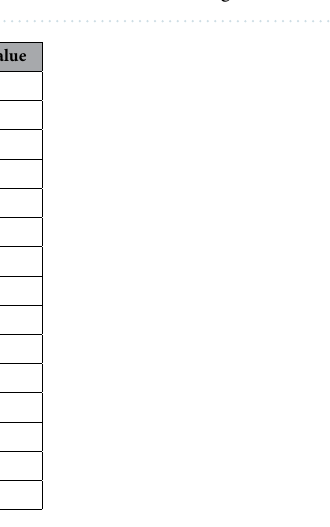
Figure 4. Stress test; changes of performance according to the increment of data size in training set.